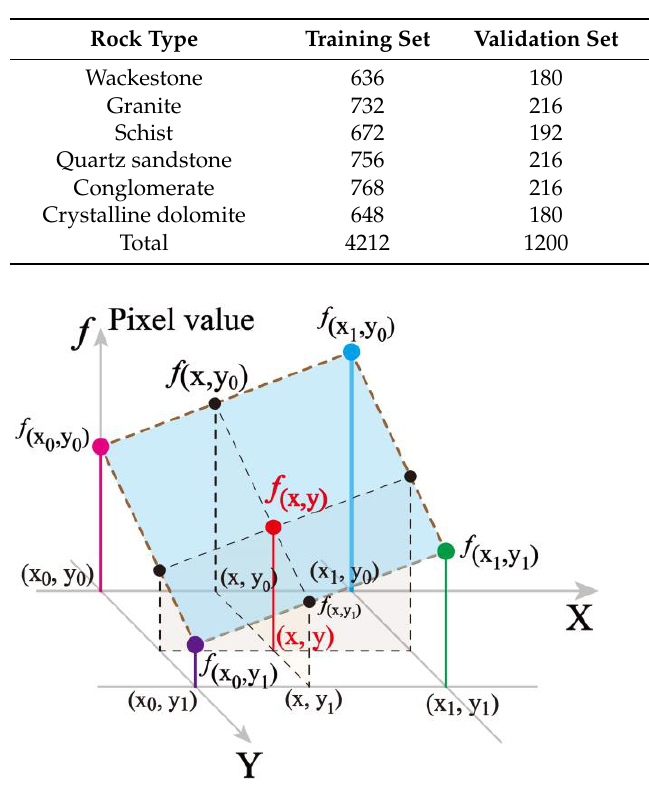
Figure 2. The calculation process of the bilinear interpolation algorithm.